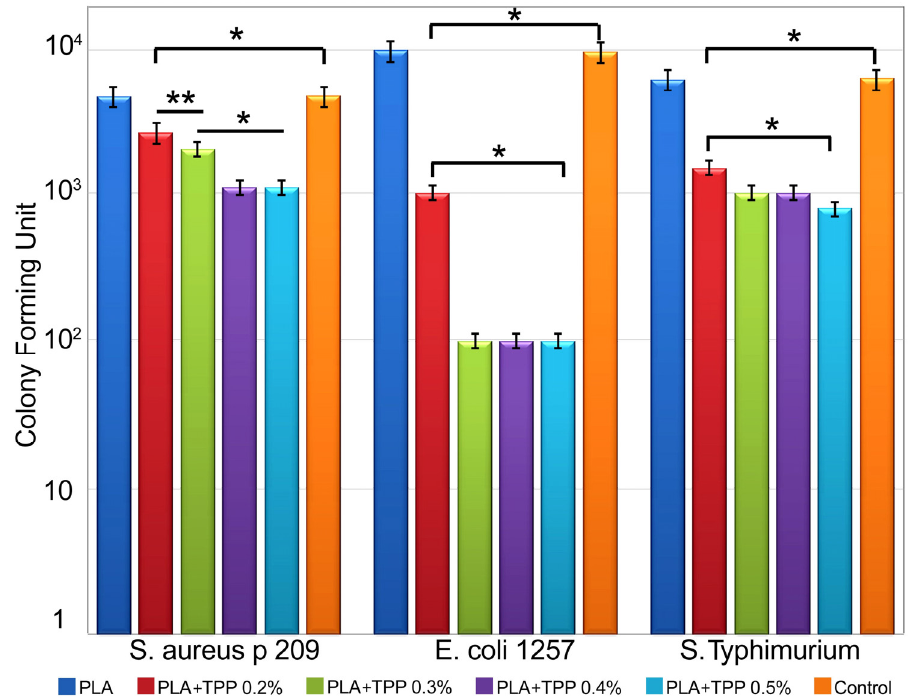
Figure 7. Biological activity of PLA and PLA–TPP4OC 6 composites. The data are shown as the mean ± SD (n = 5). * represents significant differences p < 0.001, and ** represents p < 0.05.